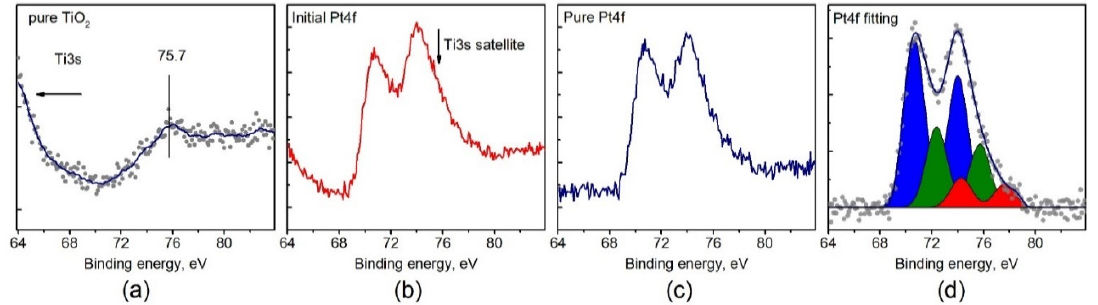
Figure 7. ( a ) The XPS spectrum of Ti3s satellite for pure TiO 2 support; ( b ) the experimental XPS spectrum of the Pt4f region for Pt / TiO 2 catalyst; ( c ) the Pt4f spectrum after Ti3s satellite subtraction; ( d ) the curve-fitted Pt4f spectrum.